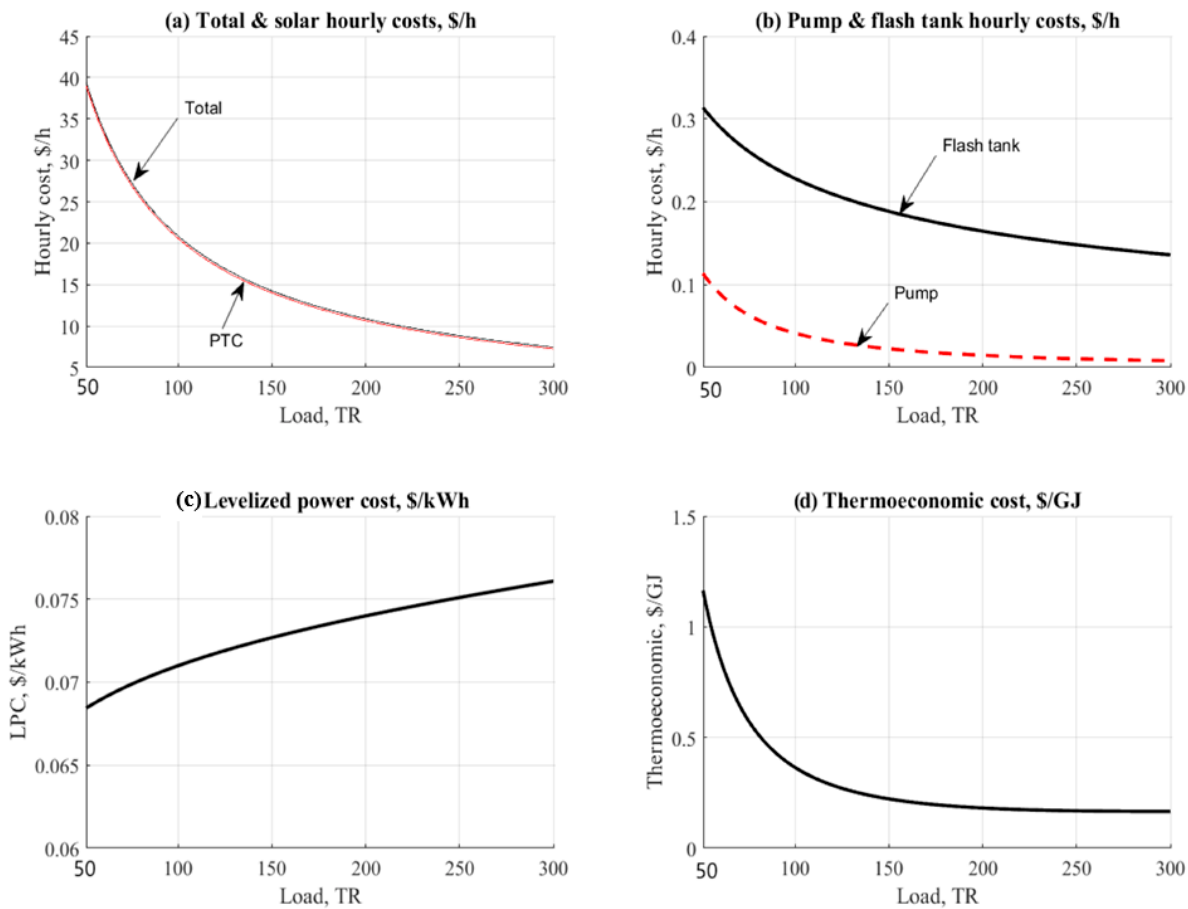
Figure 9. Data results for PTC/NH3 ‐ H2O cycle vs. cooling load. ( a ) PTC total hourly cost. ( b ) Flash tank and pump hourly cost. ( c ) Levelized power cost. ( d ) Thermo ‐ economic product.